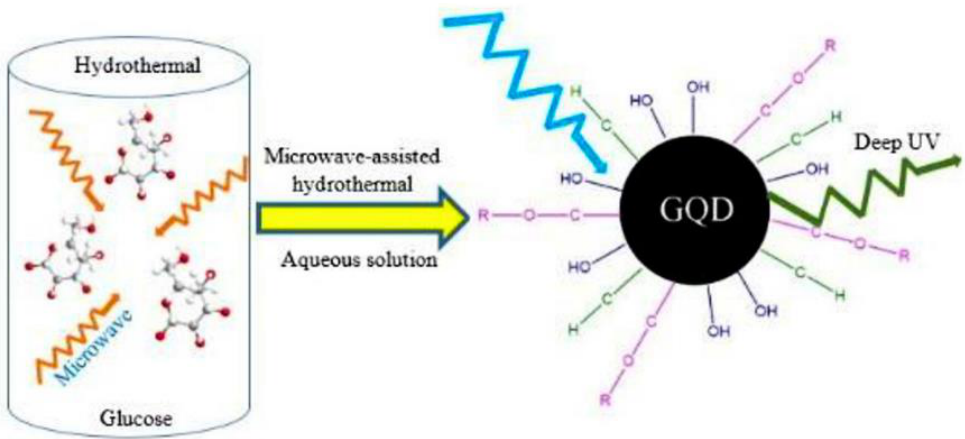
Figure 12. Illustration of synthesis of GQDs by MW-assisted hydrothermal technique. Adapted with permission from Ref. [120], Copyright (2012) American Chemical Society. A simple MW-assisted hydrothermal method was used to create glucose-derived water-soluble crystalline graphene quantum dots (GQDs) with an average diameter of 1.65 nm (5 layers).